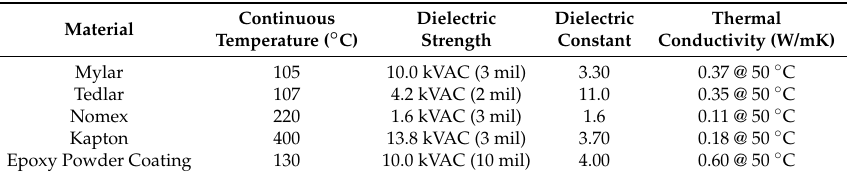
Table 3. Properties of insulation materials reported in